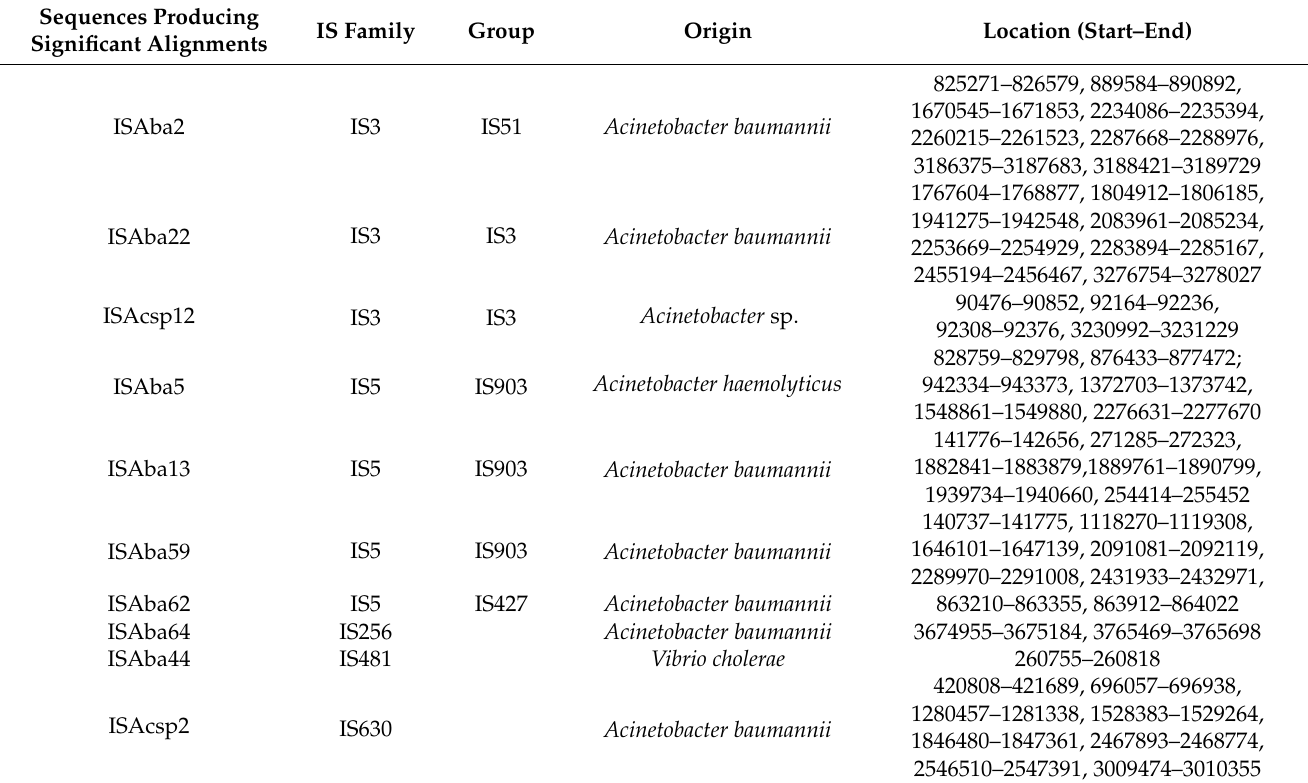
Table 3. Insertion sequences in the A. baumannii strain AB43